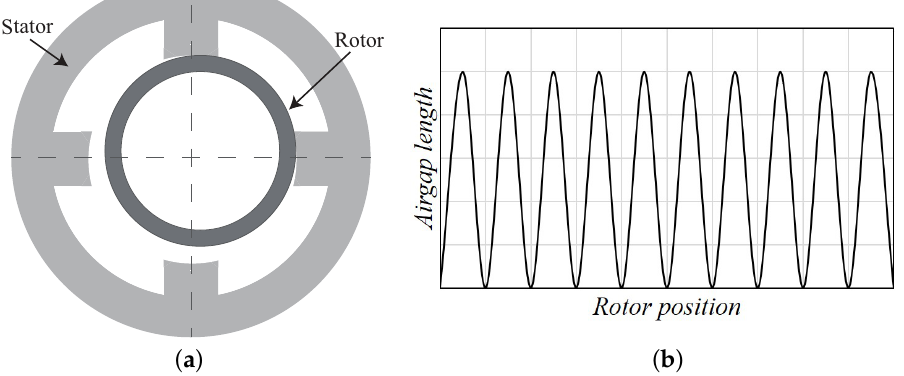
Figure 7. ( a ) switched reluctance motor with a rolling rotor, and ( b ) eccentric gap vs.